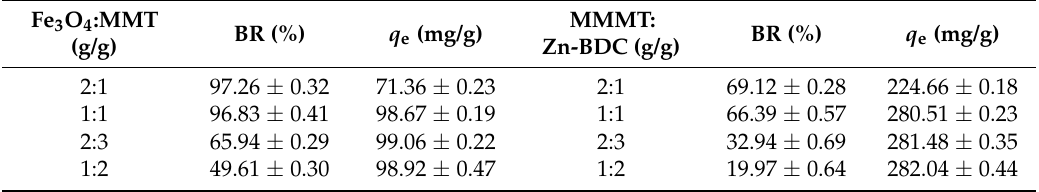
Table 1. The effect of the addition of Fe 3 O 4 , MMT, and Zn-BDC on the adsorption